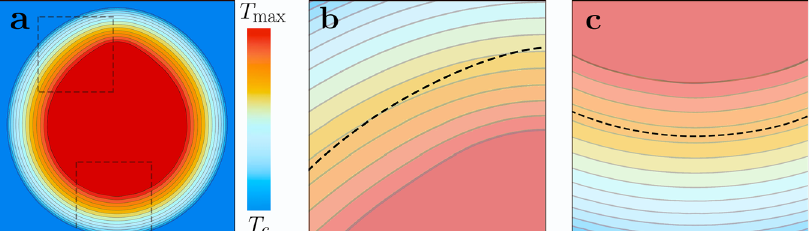
Fig. 4 Isothermals around a non-spherical particle. a Composition pro fi le ϕ ( r ) in the vicinity of an axisymmetric particle with a surface temperature above the critical value T c of water-2,6-lutidine. ϕ is constant at the isothermal surface and decreases with distance; the dark blue area indicates the range where T ≤ T ϕ T ≥ T c and where the composition takes the bulk value c . The gray lines in the critical droplet ( c ) indicate iso-compositon surfaces. b The curvature of the top of the particle is larger than that of its bottom; as a consequence, ϕ varies more rapidly close to the top and the iso-composition lines are denser. The dashed line, at a constant distance from the particle surface, crosses iso-composition lines; thus there is a composition gradient ∇ ∥ ϕ parallel to the surface, which induces a diffusio-osmotic creep velocity and results in self-propulsion of the particle. Our detailed analysis relates the particle velocity to the Fourier series of the particle shape R ( θ ). c Instead, the bottom of the particle is almost spherical with roughly constant curvature and zero creep